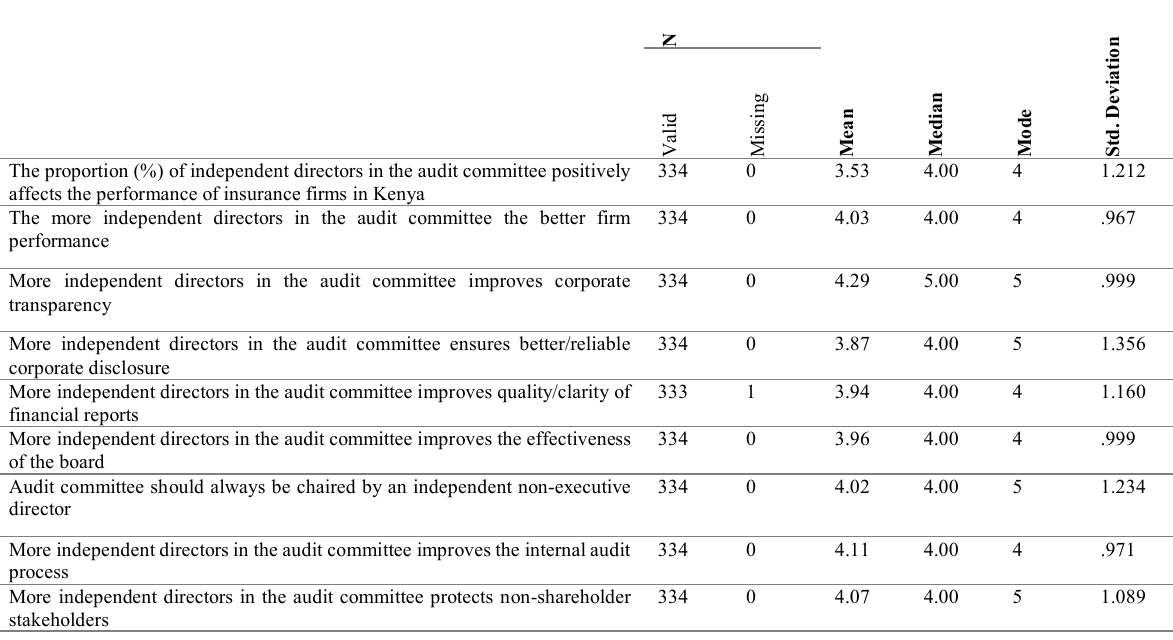
Table 3: Descriptive Statistics for Audit Committee